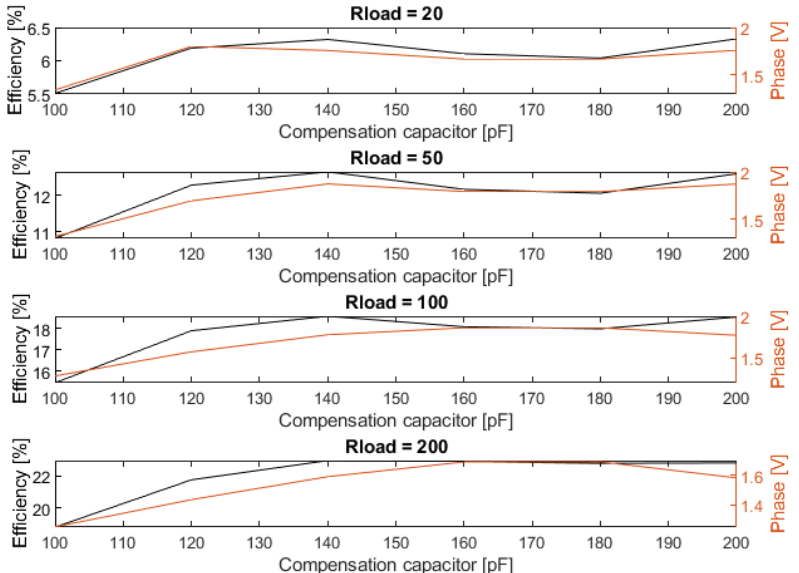
Figure 15. Measured DC efficiency and phase detector output for various DC loads at a coil distance of 1.5